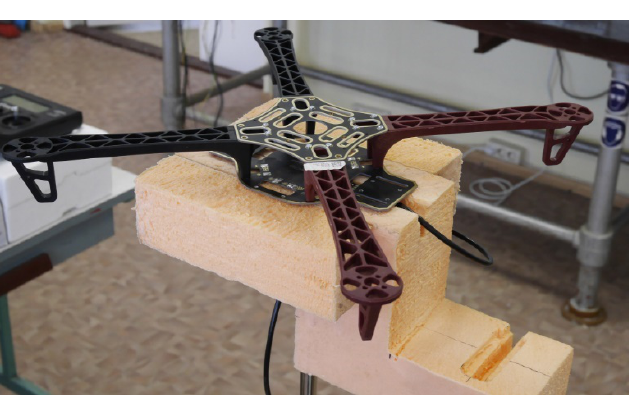
Fig. 1. Quadcopter’s “F450” frame with the attached communication module on its bottom, installed on the tripod caption.